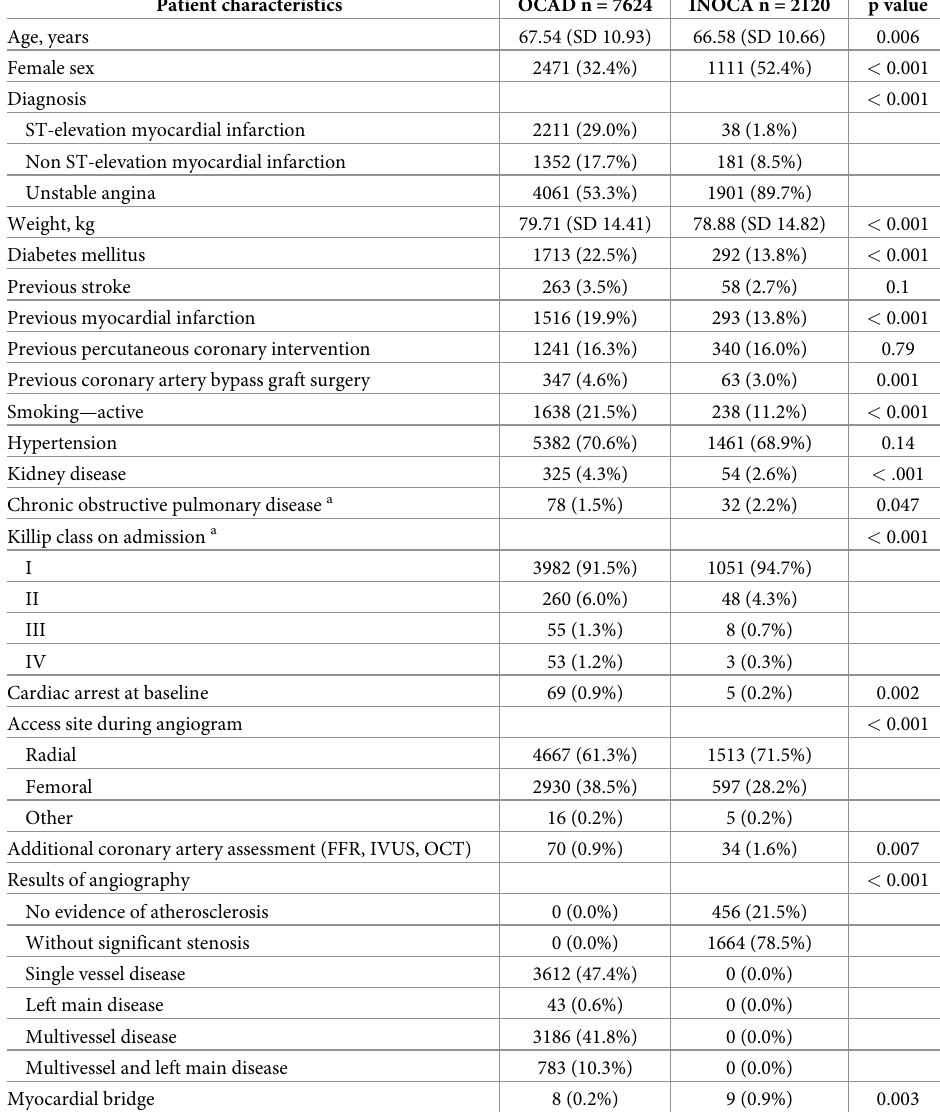
Table 1. Baseline characteristics of acute coronary syndrome patients with OCAD and INOCA.